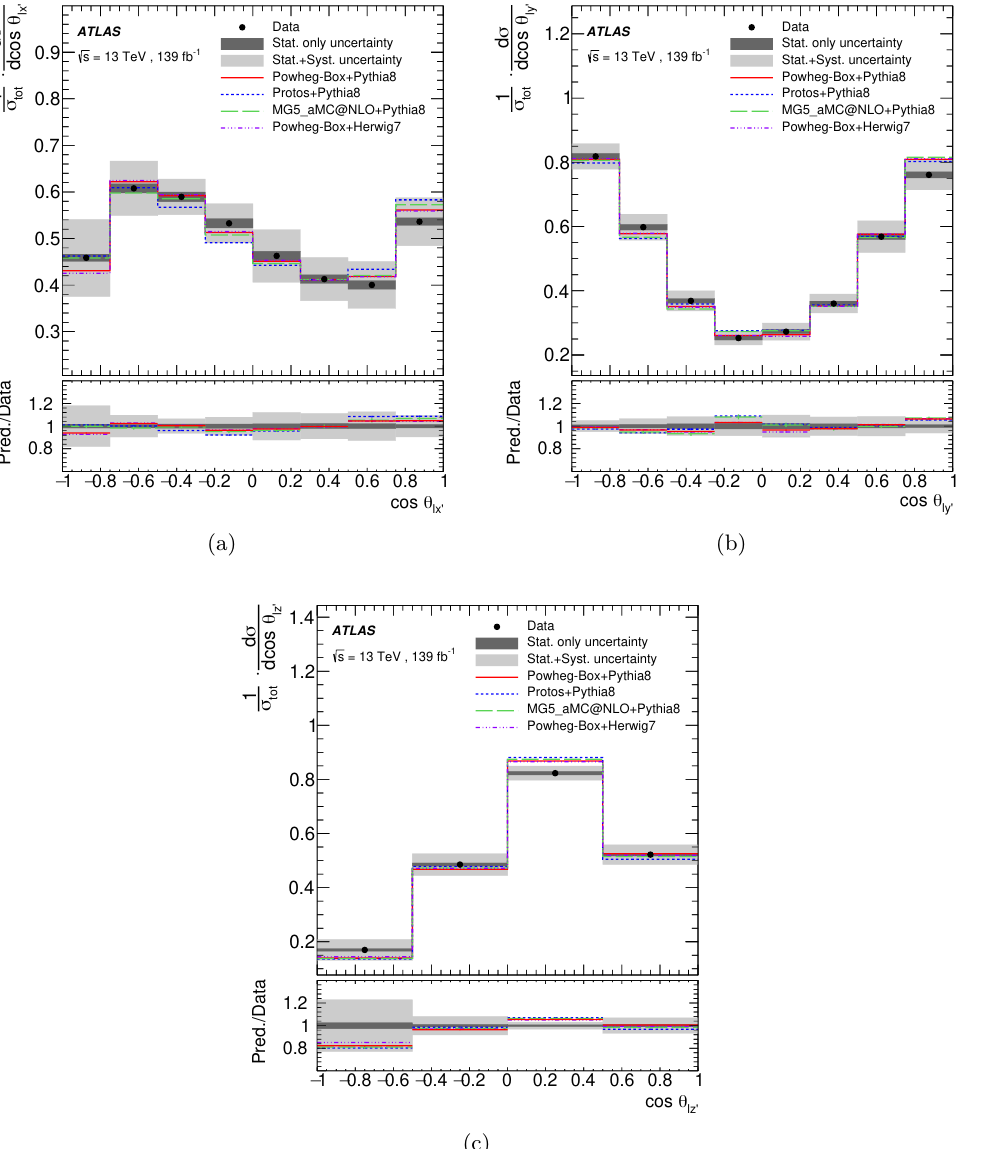
Figure 7 . Particle-level normalised differential cross-sections as a function of (a) cos θ ‘x 0 , (b) cos θ , and (c) cos θ , along with various SM MC predictions of the t -channel signal for both ‘y 0 ‘z 0 top quarks and top antiquarks. The data, shown as the black points with statistical uncertainties, are compared with predictions (lines) obtained by using the Powheg Box + Pythia 8 (solid red), Protos + Pythia 8 (dashed blue), MadGraph5_aMC@NLO+Pythia 8 (long-dashed green) and Powheg Box + Herwig 7 (dot-dashed violet) generators. The uncertainty bands include both the statistical and systematic uncertainties. The data statistical uncertainty is too small to be visible. The lower panels show the ratio of prediction to data in each